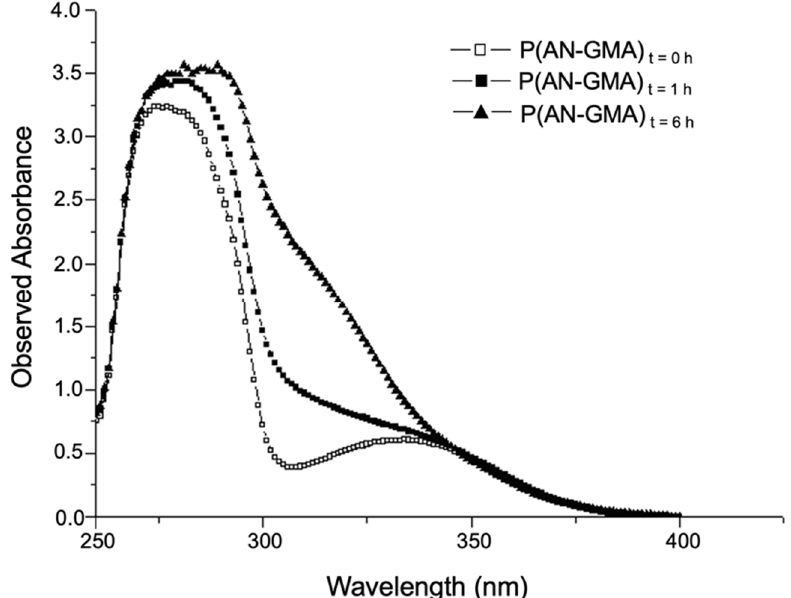
Figure 8. UV-Vis spectra of AN-GMA monomer mixture (with equimolar ratio) in DMF before polymerization ( □ ), after 1 h of polymerization ( ■ ), and after 6 h of polymerization ( ▲ ).